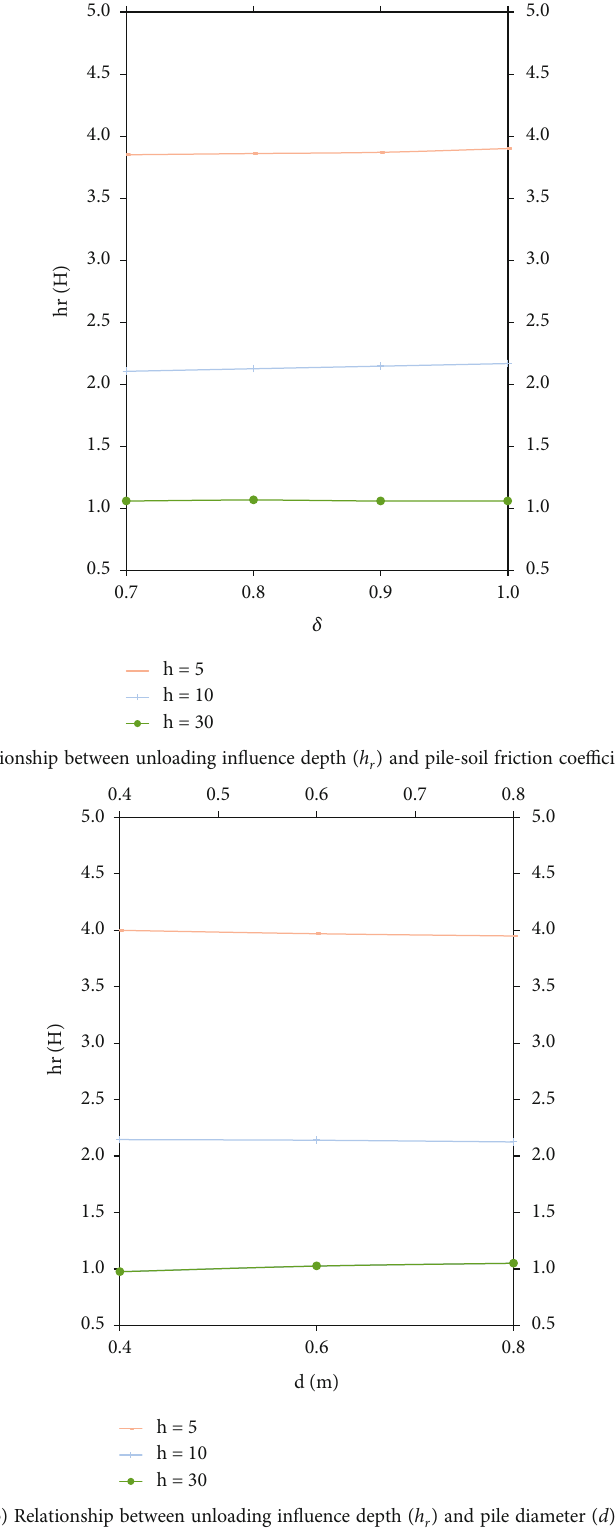
Figure 6: The relationship between unloading in fl uence depth ( h